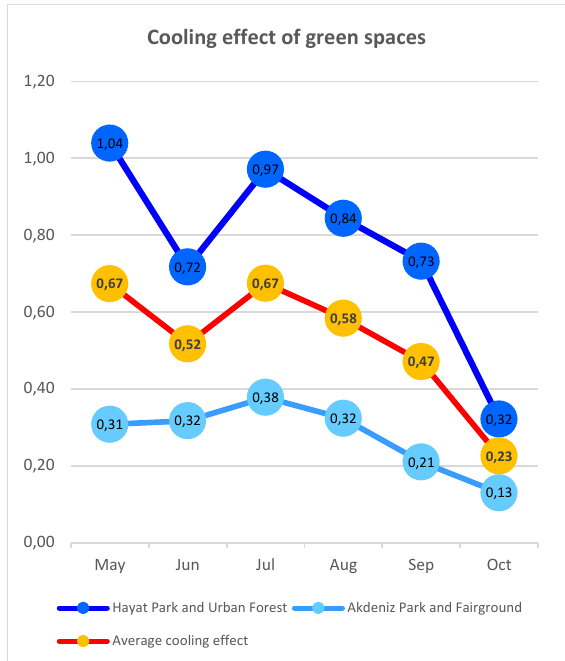
Figure 6 . Cooling effect og green spaces in